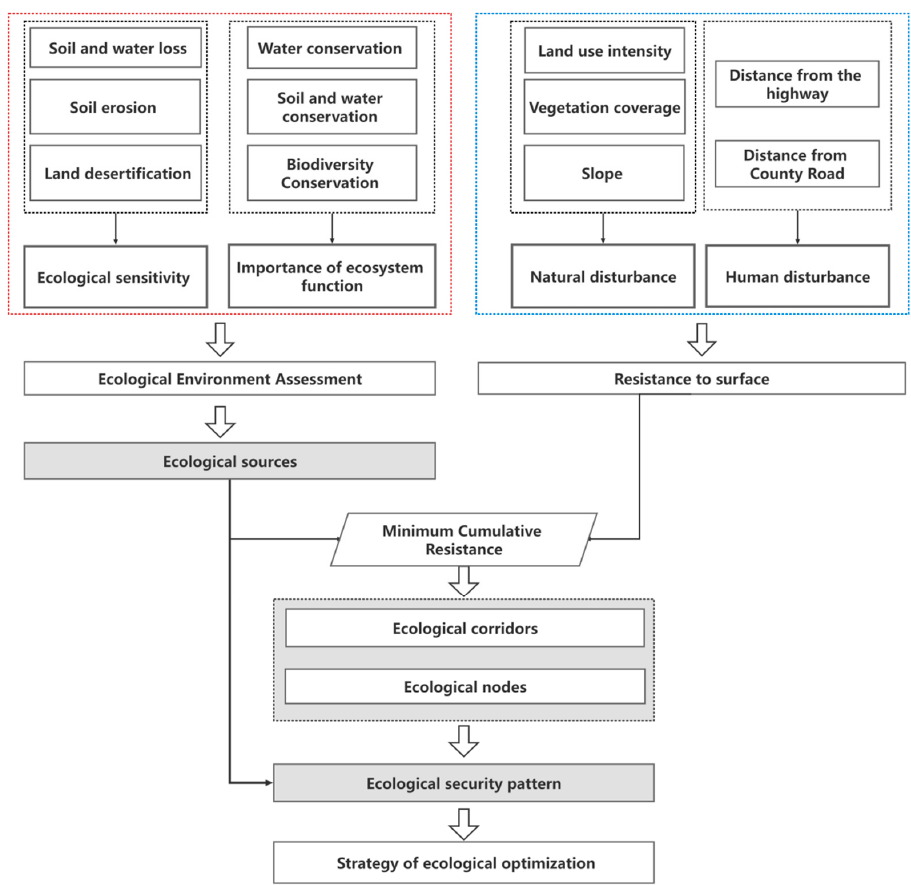
Figure 2. The methodological framework of the study.